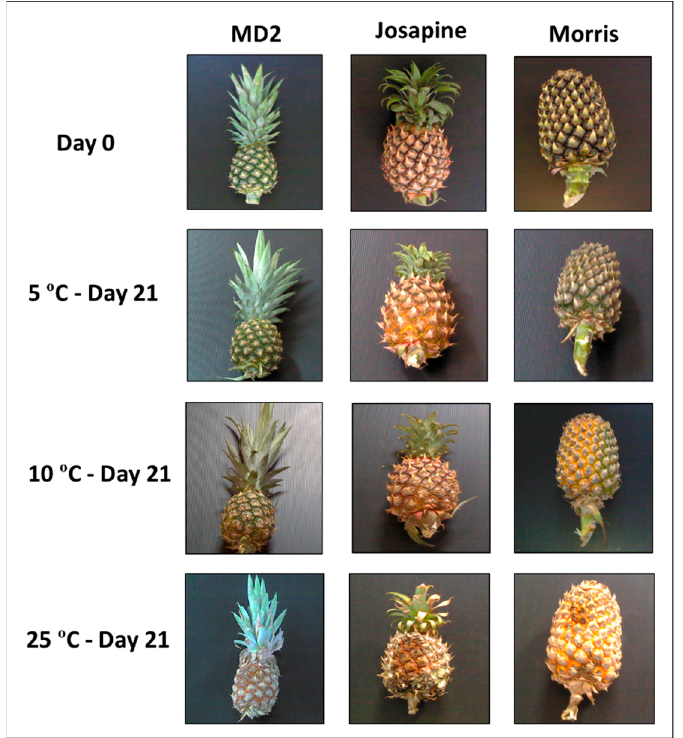
Figure 1. The images of different varieties of pineapple before storage (Day 0) and at the end of storage (Day 21) subjected to different storage temperatures.